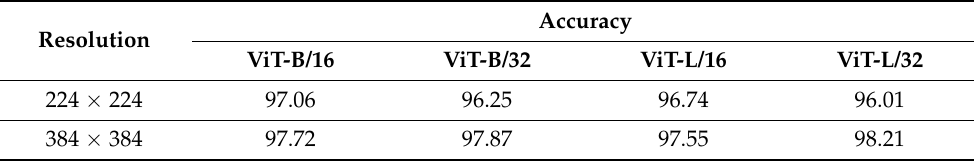
Table 3. Test accuracy values are given in percentages for ViT-B/16, ViT-B/32, ViT-L/16, and ViT-L/32 for both resolutions of 224 × 224 and 384 × 384. ViT: vision transformer, B: base, L: large.